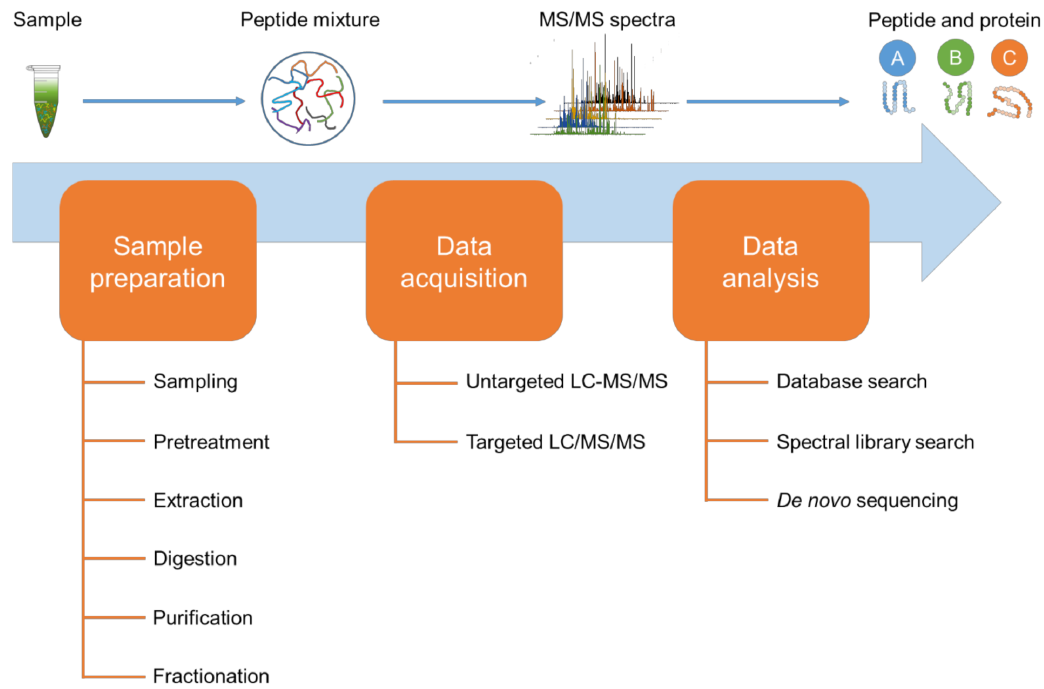
Figure 1. Overview of bottom-up